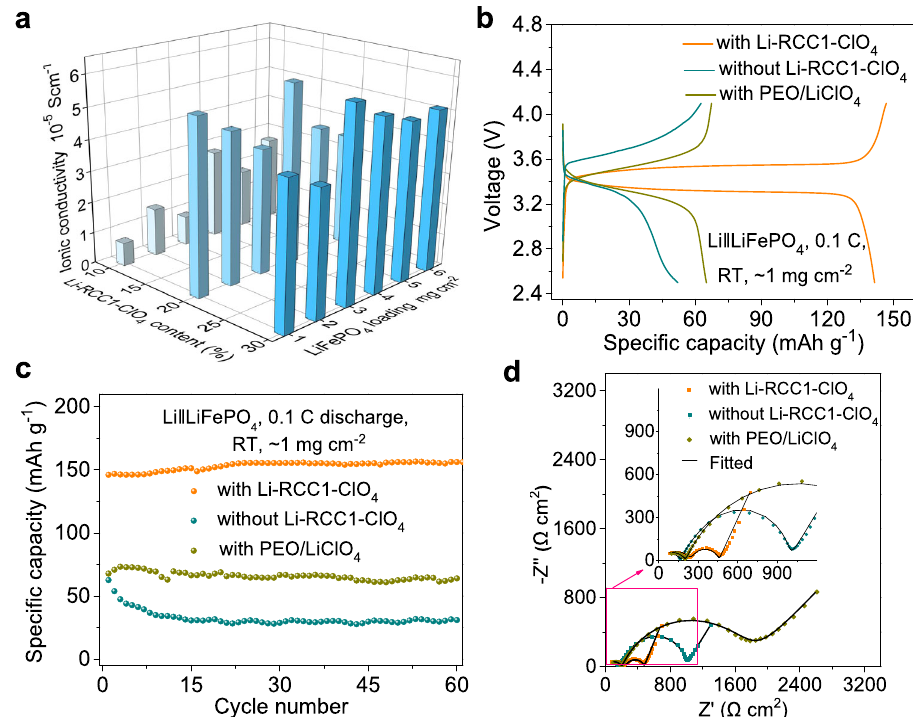
Fig. 4 Electrochemical performance of the all-solid-state battery with ionic conducting cage catholyte Li-RCC1-ClO 4 . a Comparison of the ionic conductivities of the solid cathodes with different Li-RCC1-ClO 4 content and LiFePO 4 areal loading. Note: the cyan from light to dark symbol represent solid-state cathode with 10%, 20% and 30% Li-RCC1-ClO 4 electrolyte, respectively; The detailed values are provided in Supplementary Table 1. b Voltage pro fi les, c cycling performance, and d Electrochemical impedance spectra pro fi les of the SSLBs at room temperature using LiFePO 4 solid-state cathodes (loading: ~1.0 mg cm − 2 ) with and without Li-RCC1-ClO 4 , as well as with PEO/LiClO 4 polymer as the catholyte. The inset in 4d shows the enlarged impedance curves of the red square. The fi tted modal is shown in Supplementary Fig.